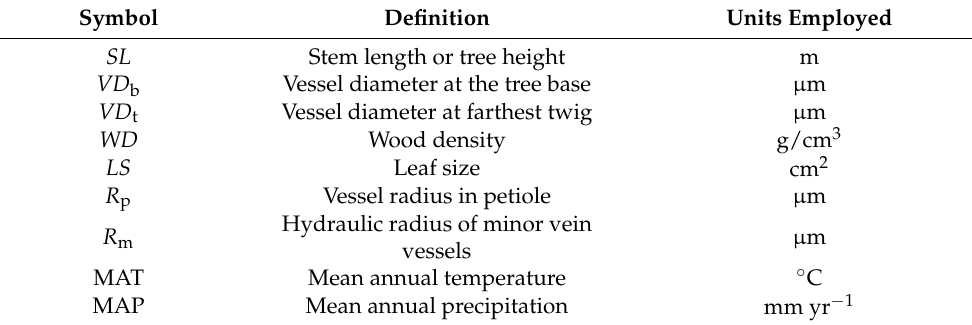
Table 1. Definitions of traits and environmental variables studied and units